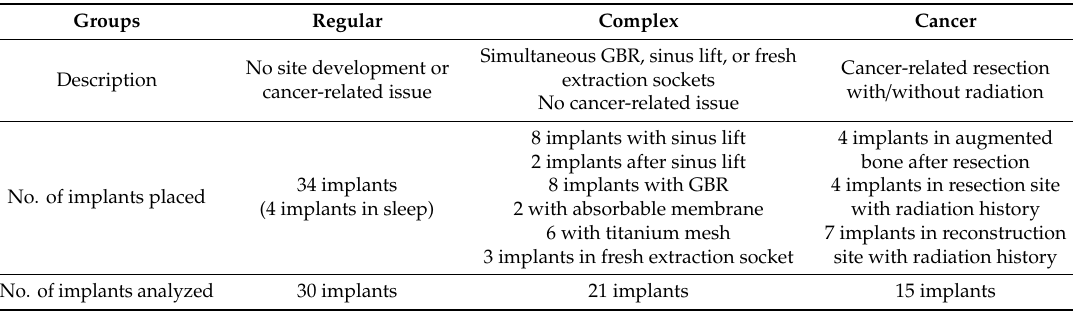
Table 1. Case descriptions of the present